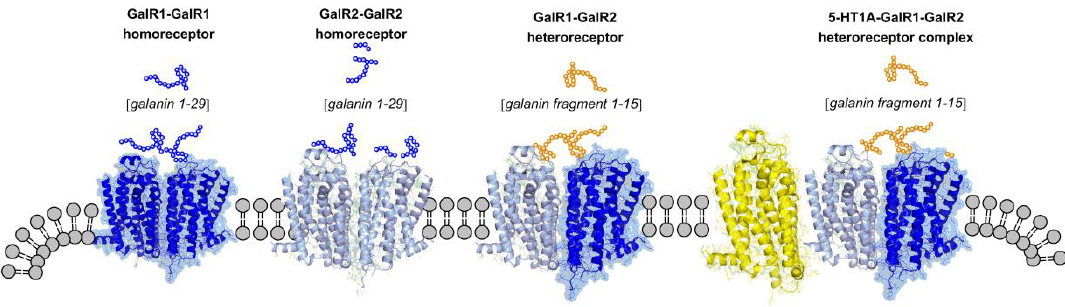
Figure 2. Illustration of the GalR1 and GalR2 homoreceptor complexes and the GalR1–GalR2 and 5-HT1A–GalR1–GalR2 heteroreceptor complexes in the plasma membrane. The major endogenous ligand for GalR1 and GalR2 homodimers is galanin 1–29, while the major ligand for the GalR1–GalR2 heterodimer is galanin 1–15. In the heterotrimer 5-HT1AR–GalR1–GalR2, the galanin fragment 1–15 may enhance the signaling of the 5-HT1A receptor protomer via a facilitatory allosteric receptor–receptor interaction involving mainly GalR2–5-HT1A receptor–receptor interactions.